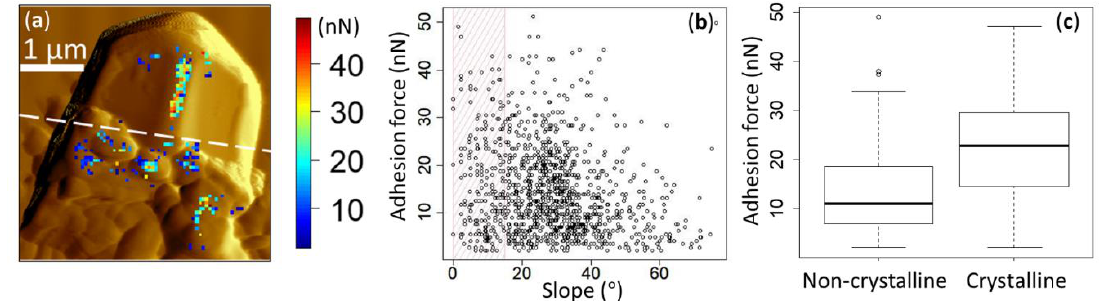
Figure 7. Example of a sea salt (SS) particle showing both crystalline and non-crystalline sections. ( a ) Composite of atomic force microscopy (AFM) mag image and adhesion force mapping. Only points with modest slope values (0–15 degrees) are shown. The white dotted line separates crystalline and non-crystalline morphological features; ( b ) slope–adhesion plot of the particle; ( c ) boxplot comparing the adhesion forces obtained from the crystalline and non-crystalline sections. The original slope and adhesion force mapping images can be found in Figure S6, along with the corresponding AFM height and phase images in the Supplementary Information